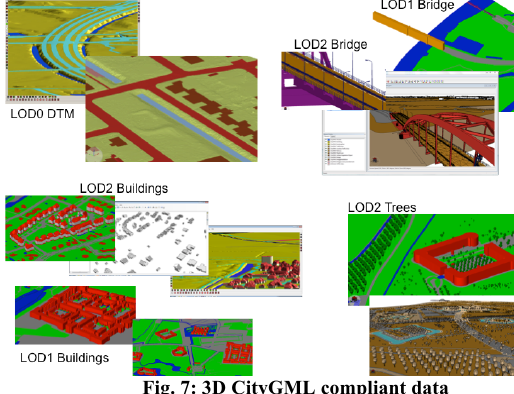
Fig. 7: 3D CityGML compliant